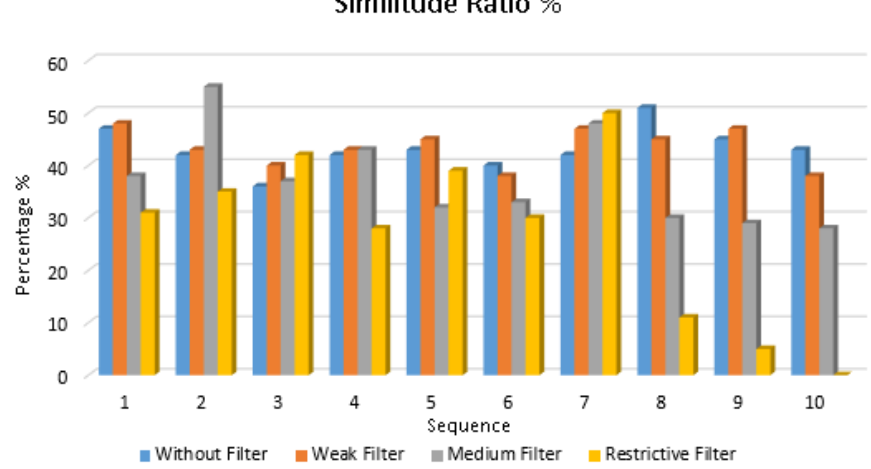
Figure 12. Similitude algorithm results for unfiltered input event data and three LDSI configurations: weak, medium and restrictive. As different scenes appear over time, the similitude ratio slightly changes. Low and medium LDSI configurations provide similar results to the original, at a higher data